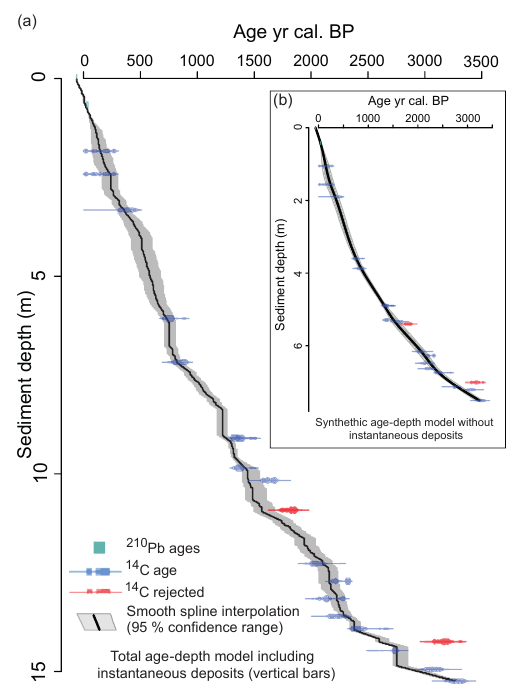
Figure 6. (a) Age–depth model for entire LAU11 sediment se- quence including instantaneous deposits based on short-lived ra- dionuclides and radiocarbon derived ages. (b) Synthethic age–depth model free of events for